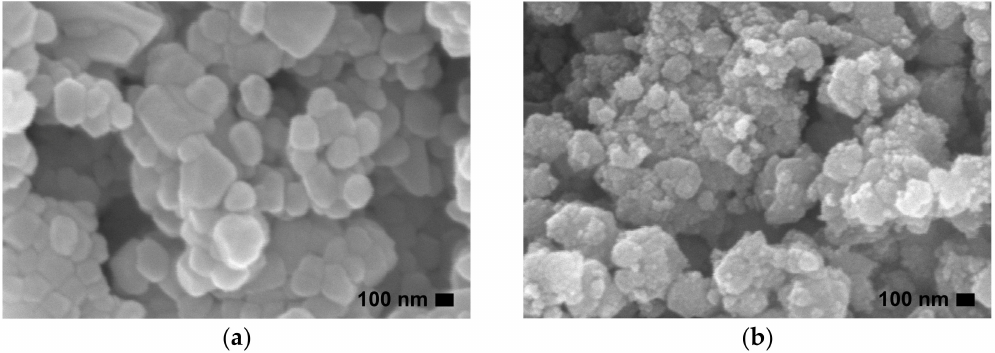
Figure 2. SEM morphological images of ZnO prepared by ( a ) precipitation and ( b ) combustion.